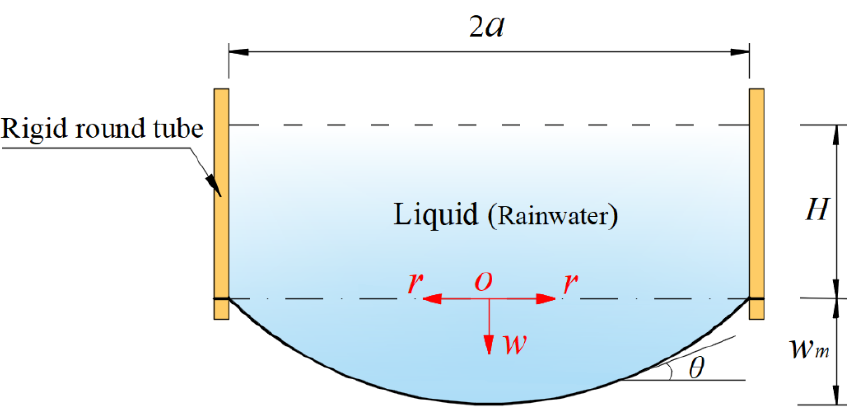
Figure 1. Geometry of the circular membrane under liquid weight loading.